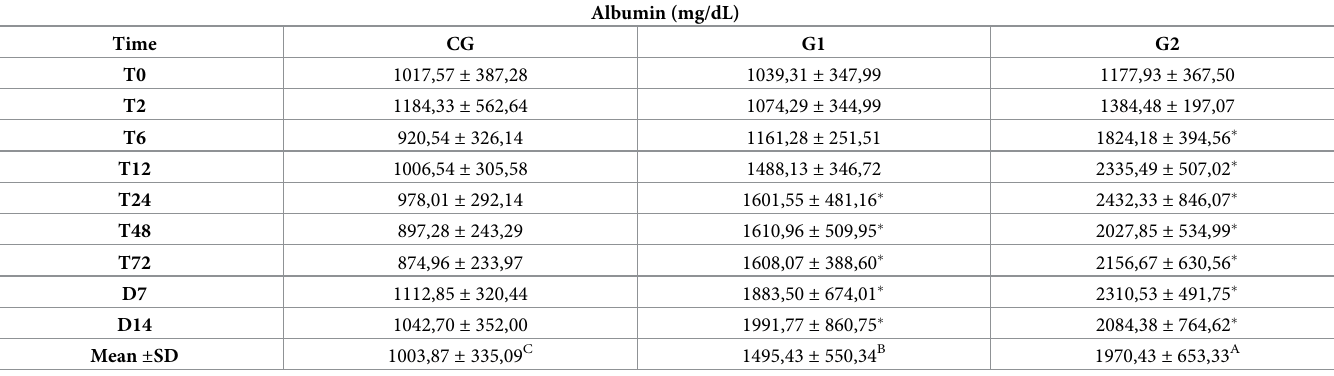
Table 9. Mean and standard deviation (SD) of albumin in the peritoneal fluid of healthy horses (CG) and horses submitted to cecal trocarization with a cecal needle (G1) or a cattle trocar (G2).